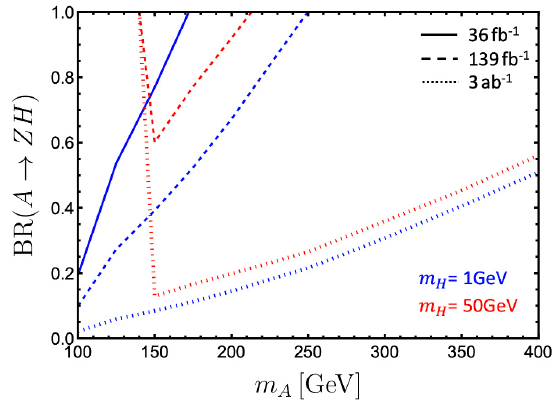
Figure 4 . Upper limits on BR( A → HZ ) from mono- Z search with m H = 1 GeV (blue) and 50 GeV (red). The solid, dashed and dotted lines correspond to the upper limits with 36 fb − 1 (solid) and 139 fb − 1 (dashed), and future sensitivity with 3 ab − 1